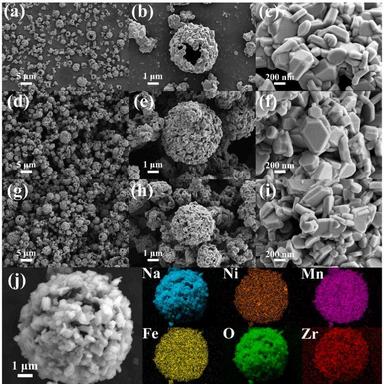
SEM images at various magnifications for NFM (a, b, c), NFM-1 %Zr (d, e, f), NFM-2 %Zr (g, h, i), and (j) EDS element mappings of NFM-1 %Zr.